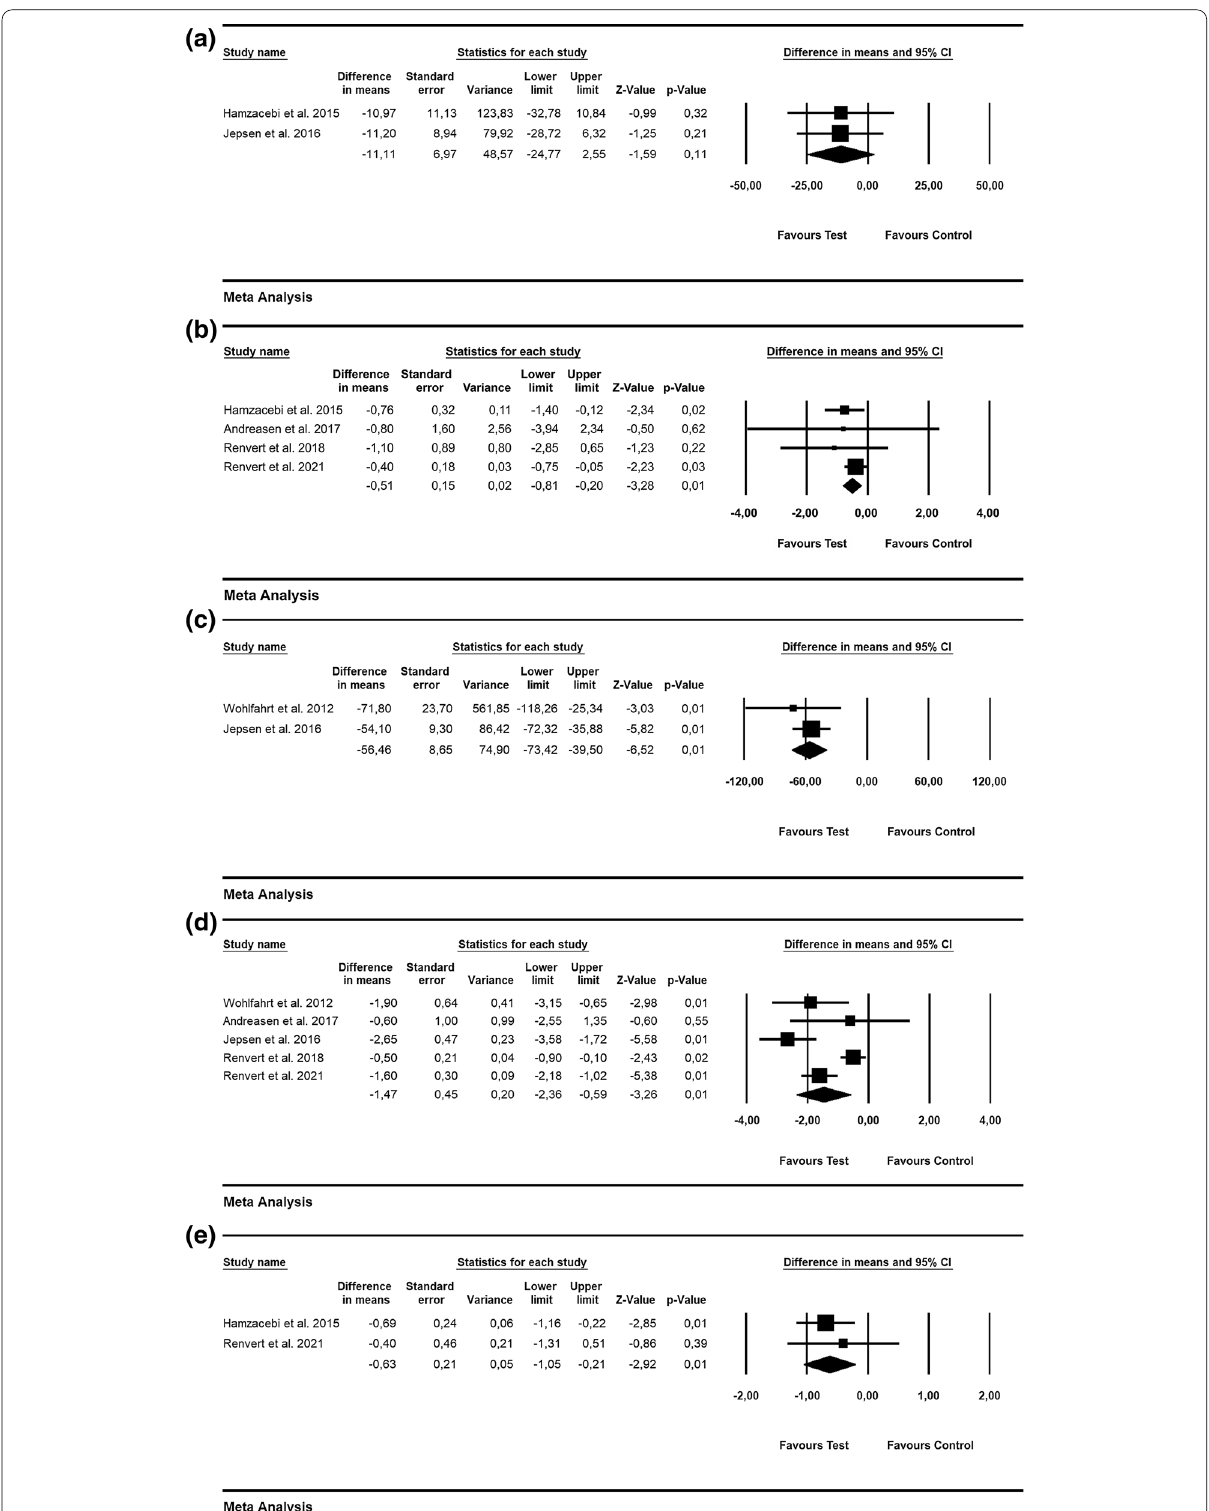
Fig. 5 Forest plots depicting weighted mean differences (95% CI) in the changes of primary and secondary outcomes between reconstructive and non-reconstructive peri-implantitis surgical treatment. a BOP reduction (implant-level analysis). b PD (mm; implant-level analysis). c RDF (%; implant-level analysis). d Radiographic defect reduction (mm; implant-level analysis). e ML (implant-level